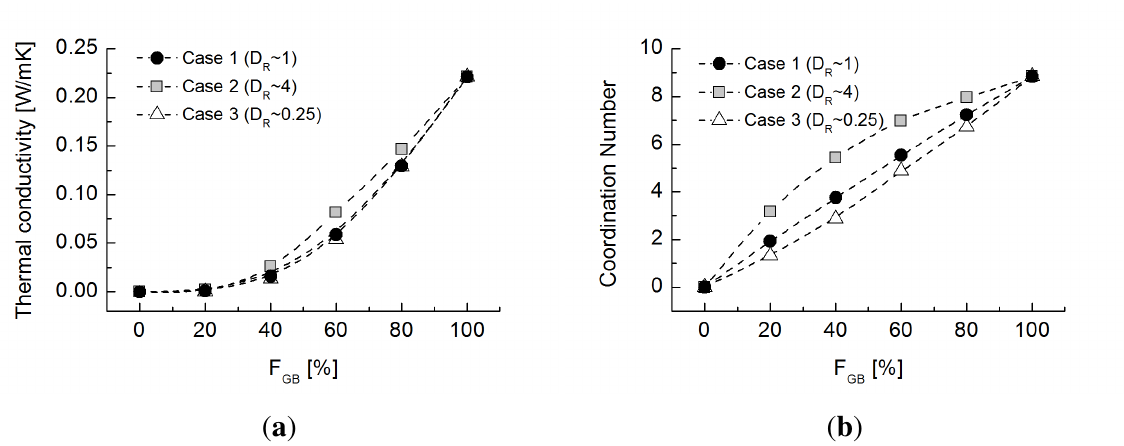
Figure 7. ( a ) Estimated thermal conductivity for Cases 1 to 3 by assuming that rubber particles are completely adiabatic (e.g., k = 0 W/mK); ( b ) coordination number among R glass bead particles for Cases 1 to